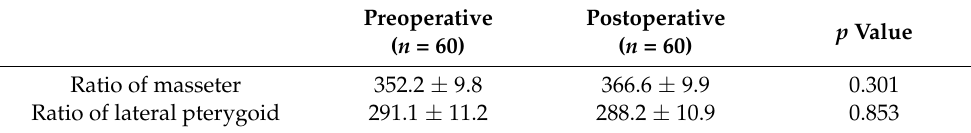
Table 1. Changes in volume-to-length ratios after mandibular